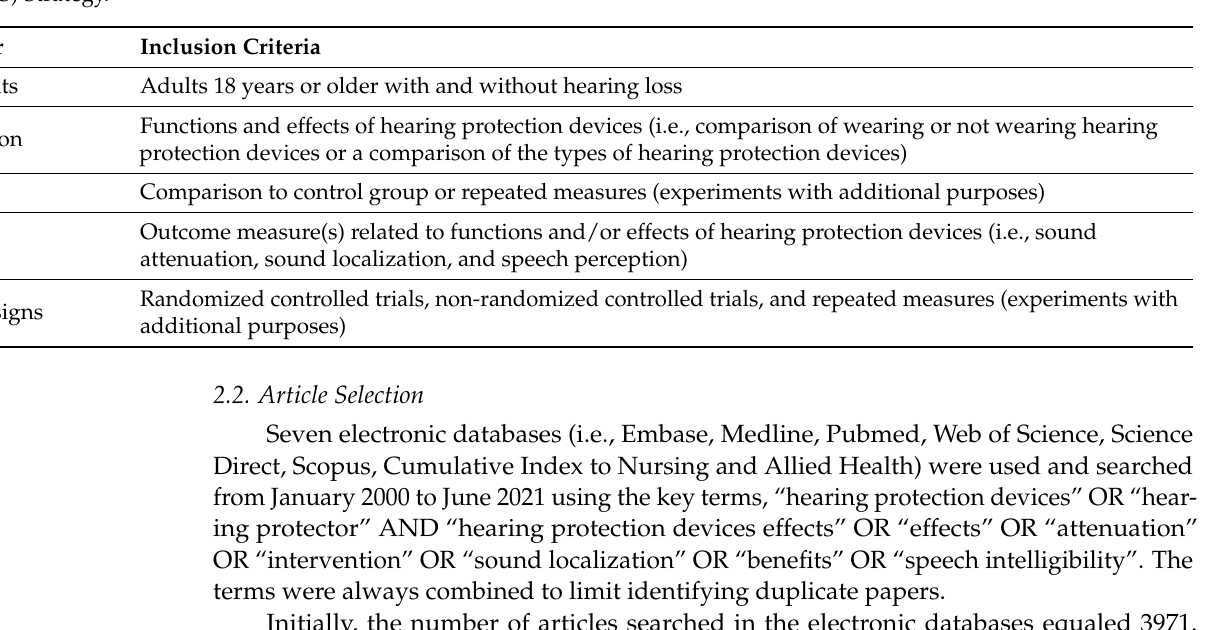
Table 1. Inclusion criteria for the present study using Participants, Intervention, Control, Outcomes, and Study Designs (PICOS)